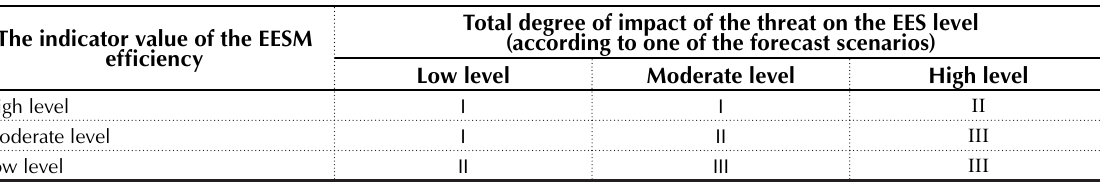
Source: Elaborated by the